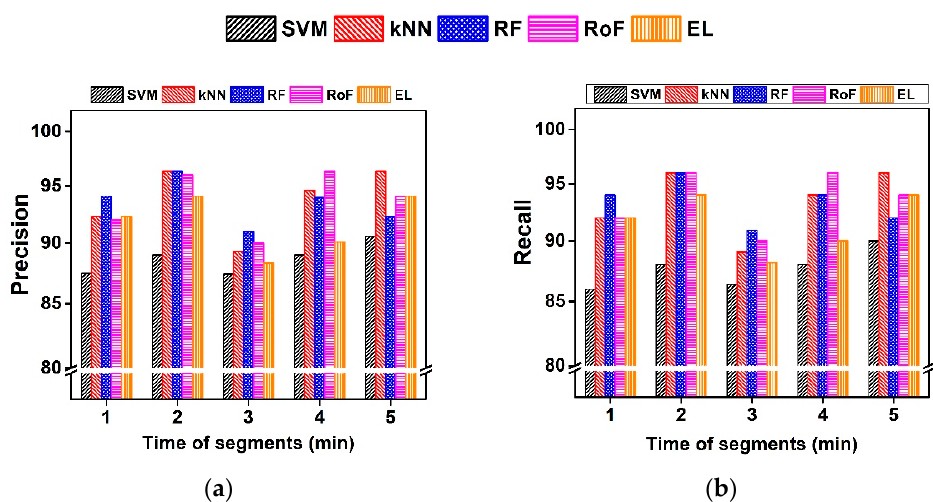
kNN Figure 9. Comparison of P ( a ) and R ( b ) obtained for a varied length of time series by the DSA method and its classification using different classifiers. Table 6. The average F (%) and AUCs (%) obtained by the DSA method for a varied length of the time segments in the AFPDB database. Bold values indicate the best performance in a column.